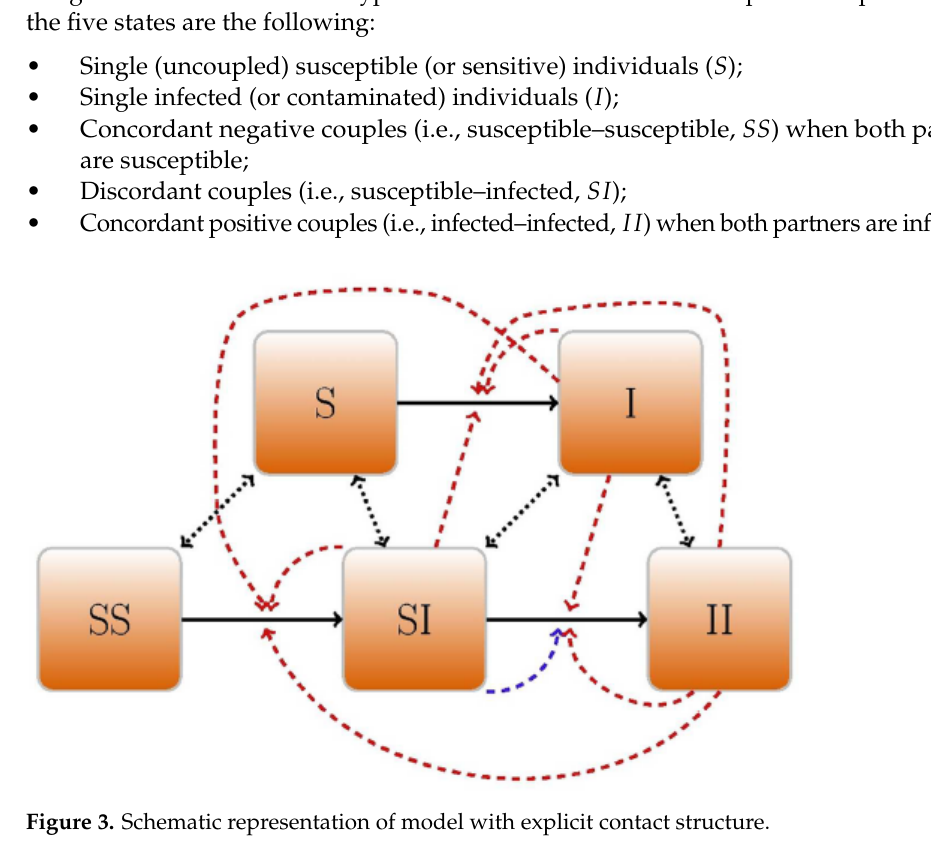
Figure 3. Schematic representation of model with explicit contact structure. Regarding schematic representation, solid arrows represent infection transitions (e.g., S towards I ), dotted arrows exhibit partnership dialysis and configuration (e.g., S towards SI ) and dashed arrows represent impacts on the rate of the infection, indicating transmis- sion among the nodes of the pair (with blue color) as well as transmission among the nodes of an uncoupled pair (with red